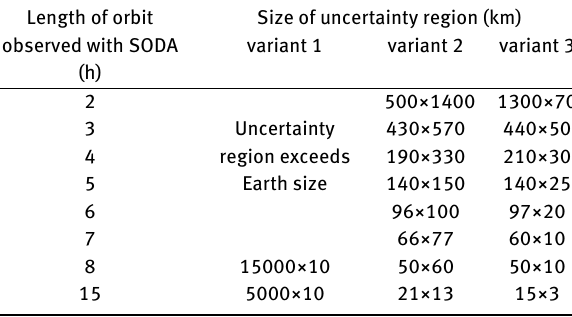
point on length of observed piece of orbit (arc) and SC configura-